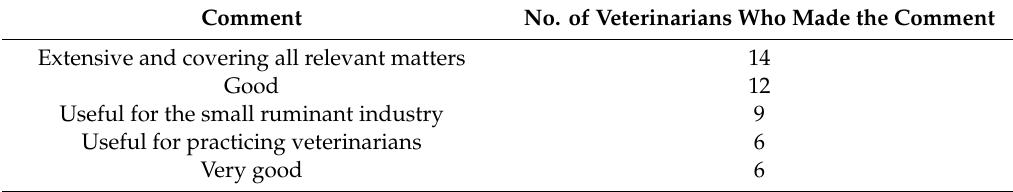
Table 3. Frequency of the various qualitative comments about the questionnaire, spontaneously made by 24 veterinarians, who attended the interviews.